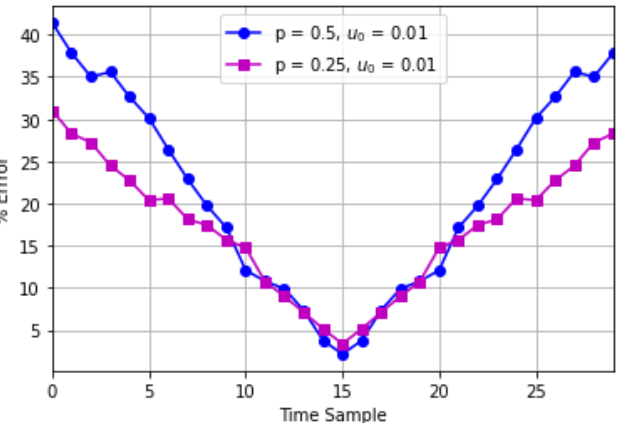
Figure 13. Average % error for an image with applied Poisson noise to CS measurements for a single-lensed microlensing event with µ 0 = 0.01 using binomial measurement matrix with p = 0.5 and p =